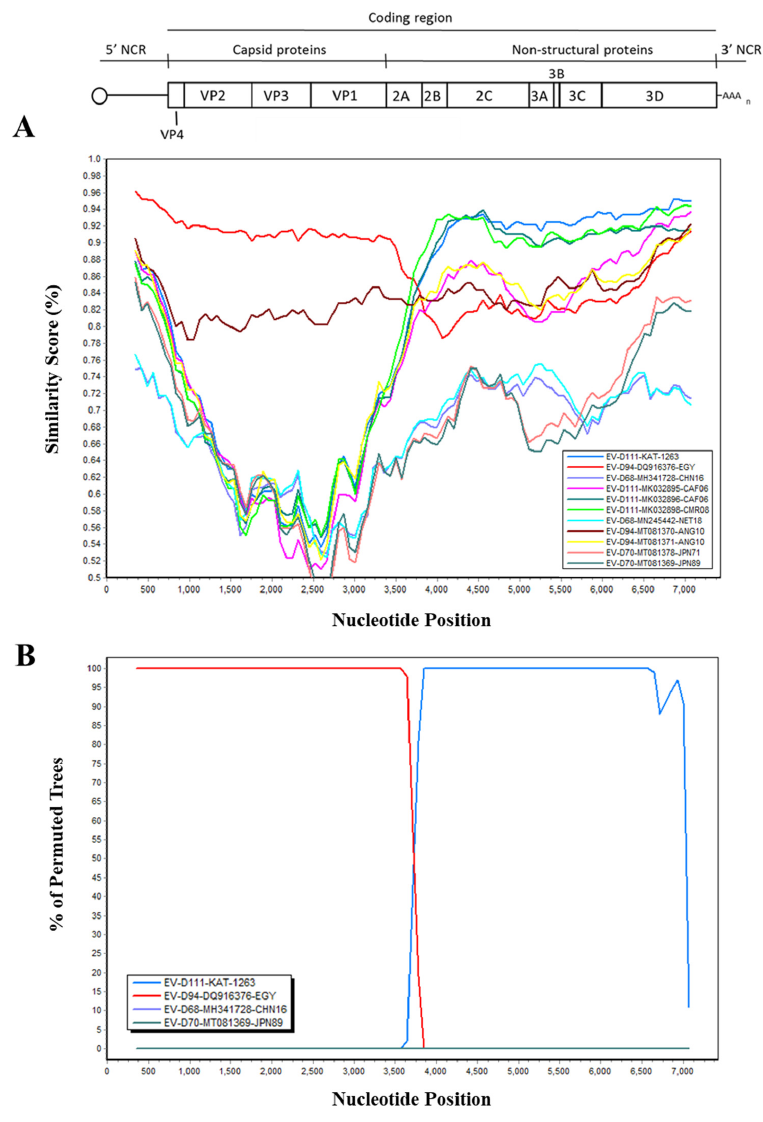
Figure 5. Recombination analysis of EV-D94-14-534 strain from Niger. Plot of similarity ( A ) and bootscanning analysis ( B ) using EV D whole-genome sequences from the NCBI sequence database. The EV genetic map is shown in the top panel. The analyses were conducted using SimPlot version 3.5.1 with the Kimura distance method and a sliding window of 700 base pairs moving in steps of 70 nucleotides. The genome of EV-D94-14-534 strain served as a query sequence.